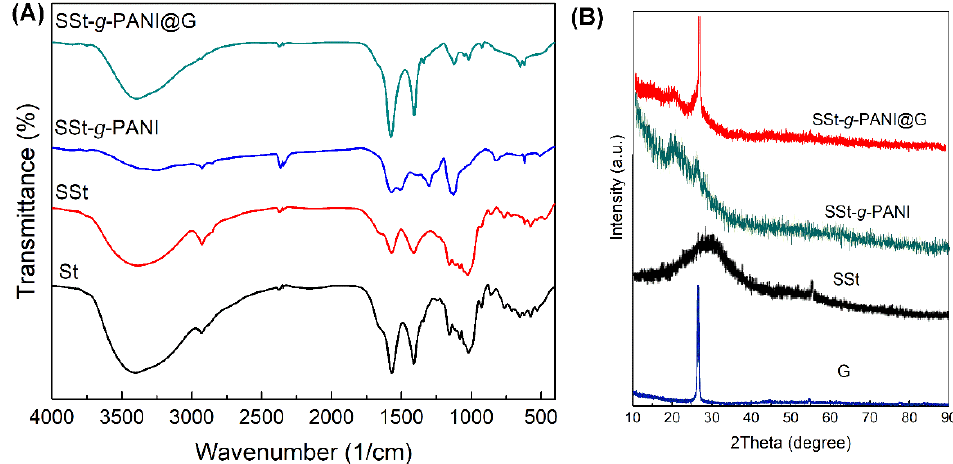
Figure 3. ( A ) FT-IR spectra of starch (St), sulfonated starch (SSt), sulfonated starch- graft -polyaniline copolymer (SSt- g -PANI), and sulfonated starch-graft-polyaniline @graphene (SSt- g -PANI@G) nanocomposite. ( B ) The XRD patterns of graphene (G), SSt, SSt- g -PANI, and SSt- g -PANI@G. The morphologies and particle size of G, SSt- g -PANI, and SSt- g -PANI@G nanocom-